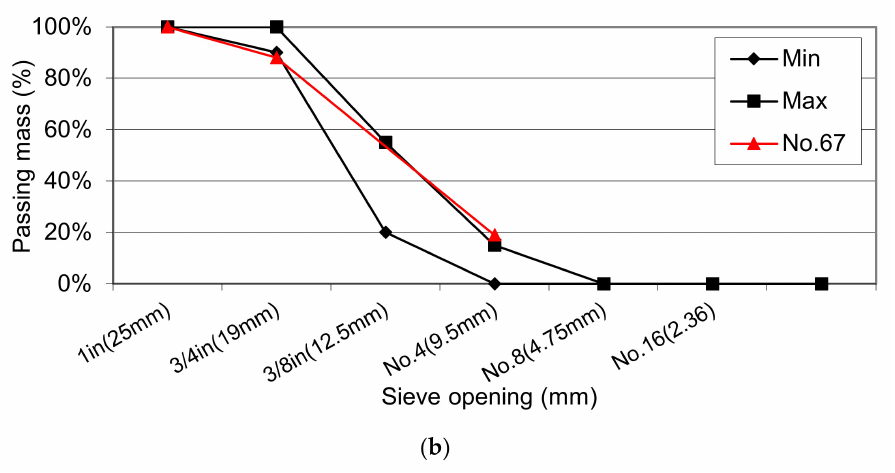
Figure 3. Granulometric curve of ( a ) shaken sand; ( b ) aggregate No.